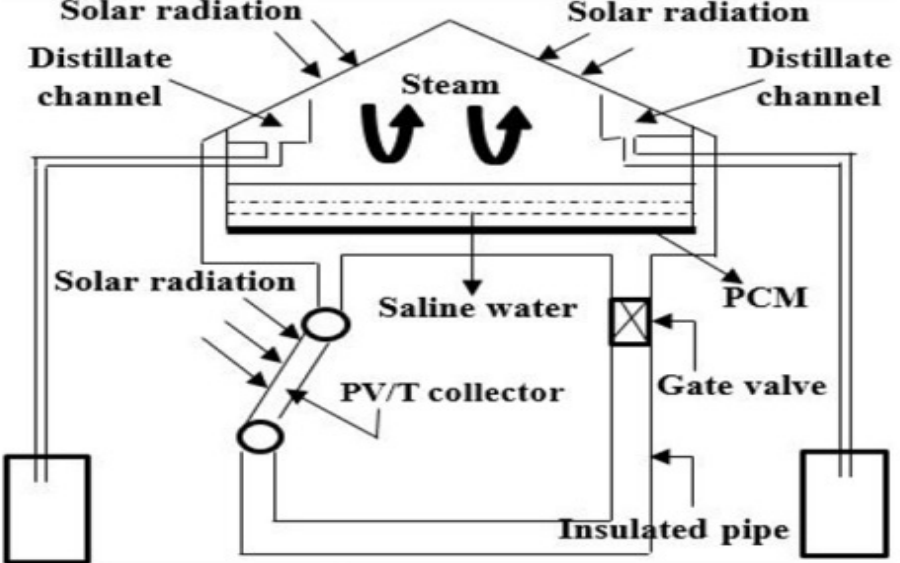
Figure 12. Diagram of the system studied by Hedayati-Mehdiabadi et al. [39]. Adapted with permission from Elsevier.